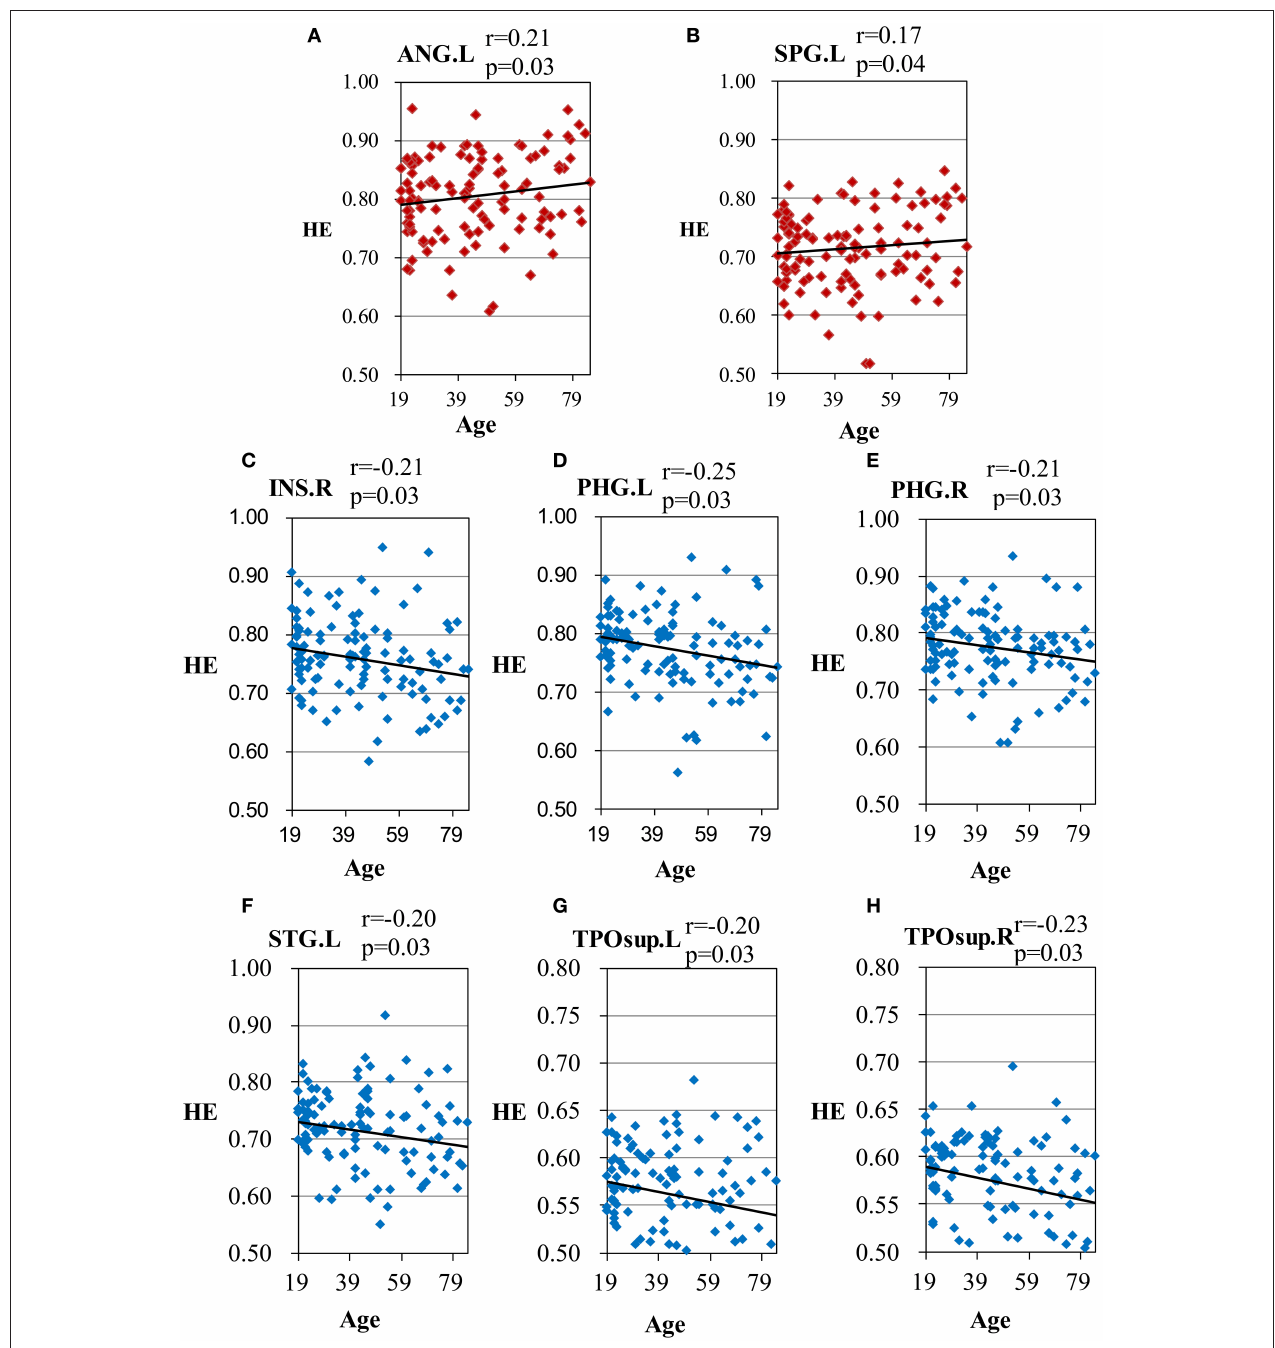
FIGURE 3 | Scatter plots for the significant correlations between age and the HE of the AAL regions. (A) ANG.L, left angular gyrus; (B) SPG.L, left superior parietal gyrus; (C) INS.R, right insula; (D) PHG.L, left parahippocampal gyrus; (E) PHG.R, right parahippocampal gyrus; (F) STG.L, left superior temporal gyrus; (G) TPOsup.L, left superior temporal pole; (H) TPOsup.R, right superior temporal pole. X-axis, age; Y-axis, the mean HE of the AAL regions. The p -values were corrected using the FDR method.